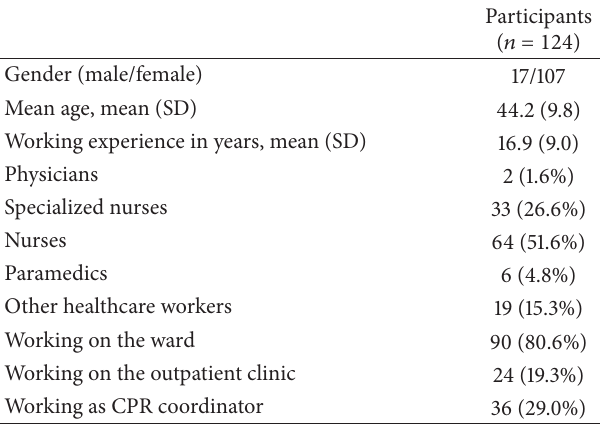
Table 5: Correlations between the seven scales of Hesitation, Nurse’s Role, Nontechnical Skill, Usefulness, Restrictions, Personal, and Organisation (1–3 attitudes towards CPR-D, 4–7 towards